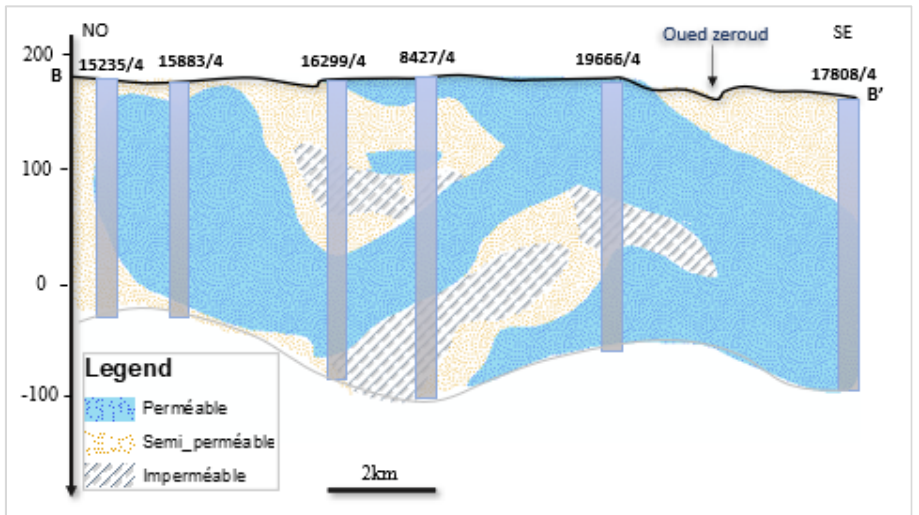
Figure 7. Cross-section BB’ between piezometers in the direction NO-SE (modified, [7]).